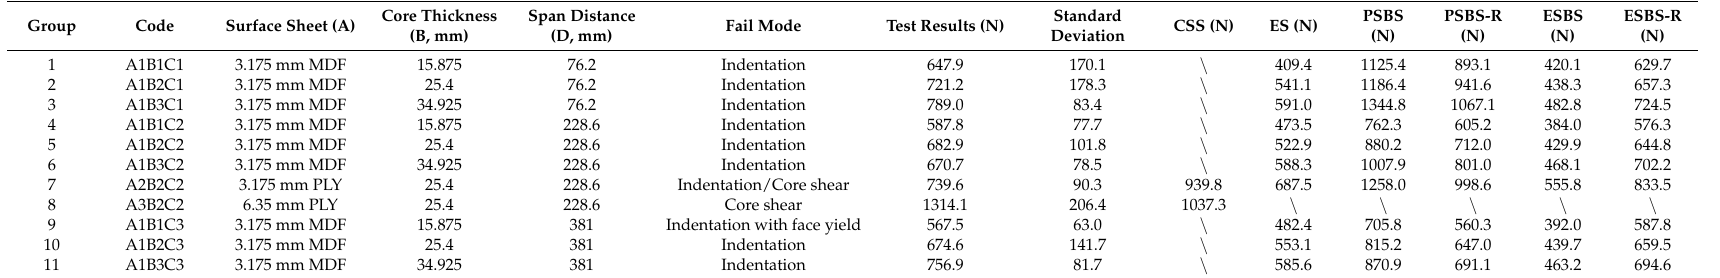
Table 4. Estimated and measured failure load of sandwich beam under three-point